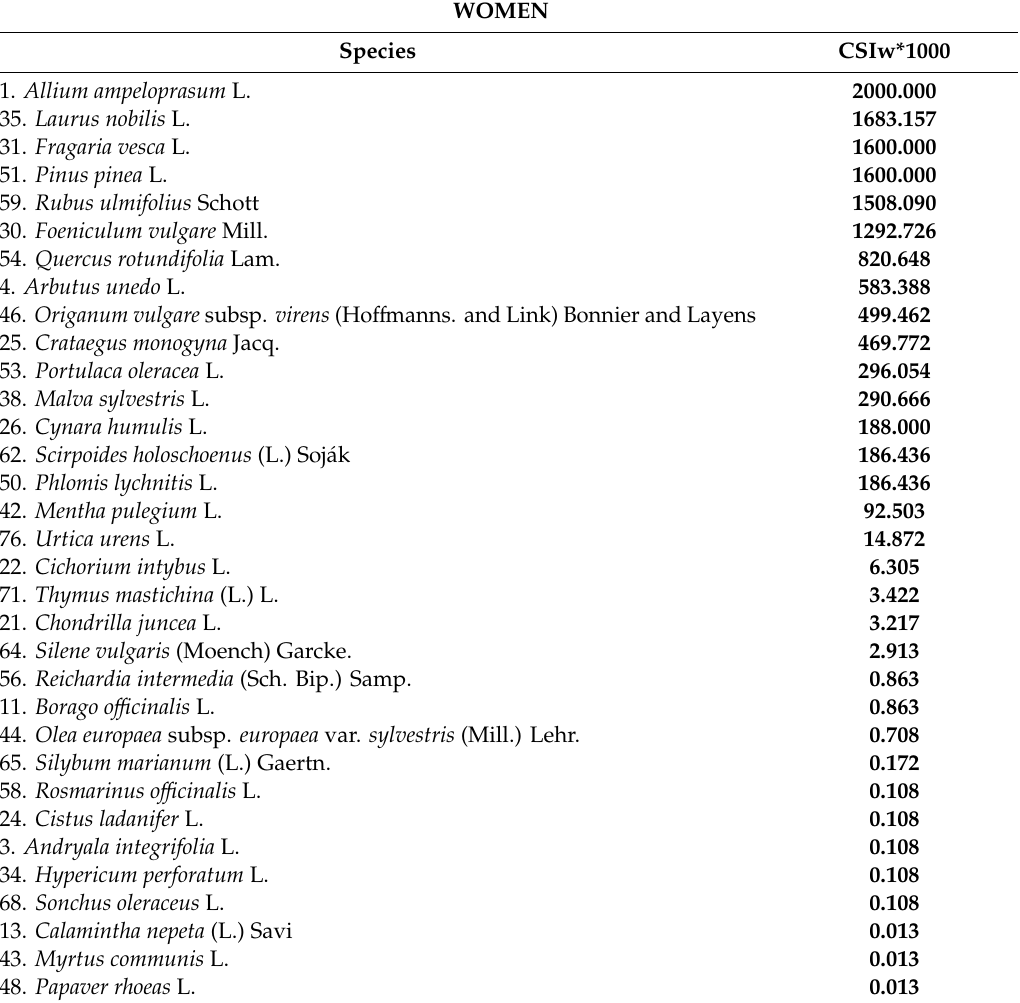
Table 5. List of taxa with the greatest importance for women ordered from highest to lowest value for